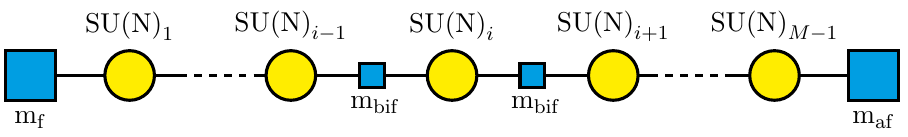
Figure 2 . Linear quiver which de(cid:12)nes multiplets for N = 1 gauge theory. Circles are for gauge vector multiplets, boxes are for